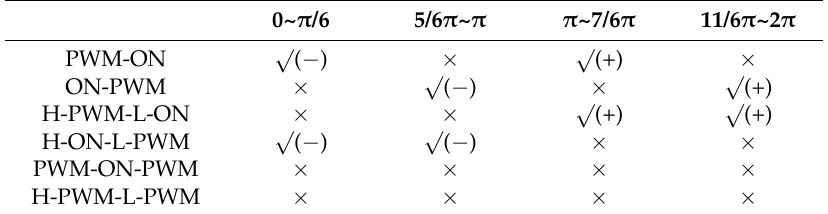
Table 4. Freewheeling currents in unexcited phase caused by different PWM methods.